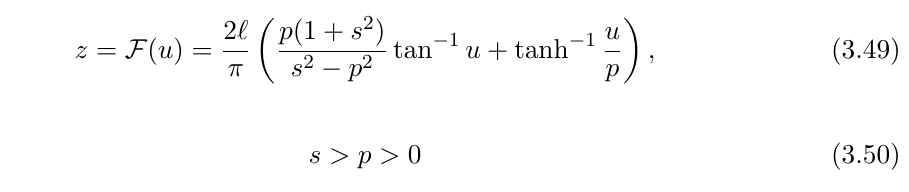
Figure 11 . Conformal transformations relating the upper half plane coordinate u , the sliver coordinate z , and the local coordinates (cid:26) and (cid:26) of the punctures of the (cid:13)ag and anti-(cid:13)ag state. e where u is the upper half plane coordinate for the (cid:13)ag-anti-(cid:13)ag surface. The relation between the sliver coordinate z and the upper half plane coordinate u is (cid:12)nally given